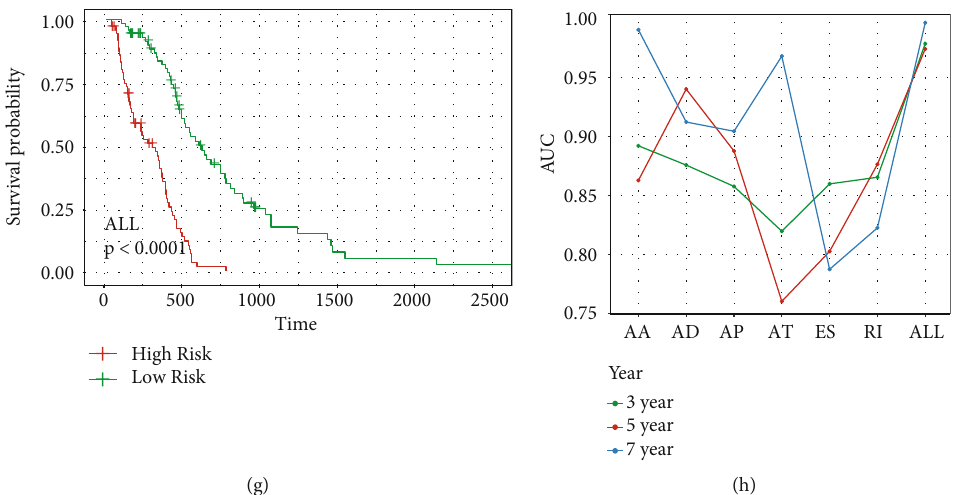
Figure 3: AS events and survival curve in glioma: (a – f) survival curve of prognostic factors related to each type of AS; (g) survival curve of the fi nal AS prognostic model; (h) various AS types and the AUC value of the ROC curve of the fi nal AS model in 3, 5, and 7